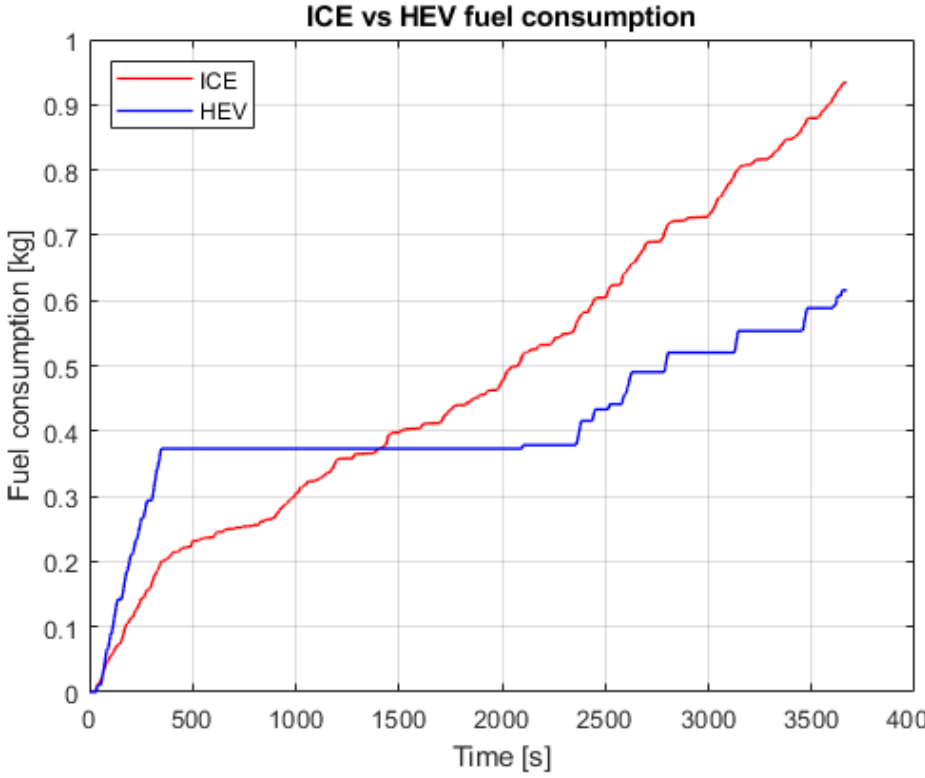
Figure 13. Fuel consumption evaluation for ICE vehicle model and HEV vehicle model.